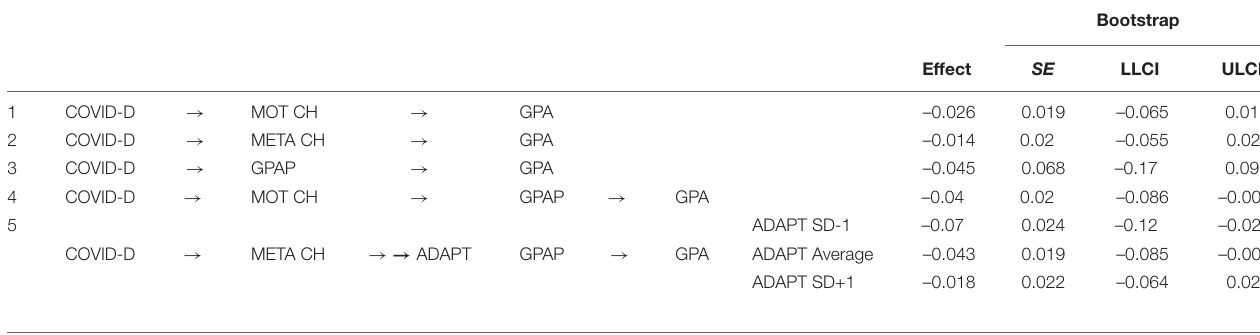
TABLE 3 | Unconditional and conditional indirect effects of COVID-D on